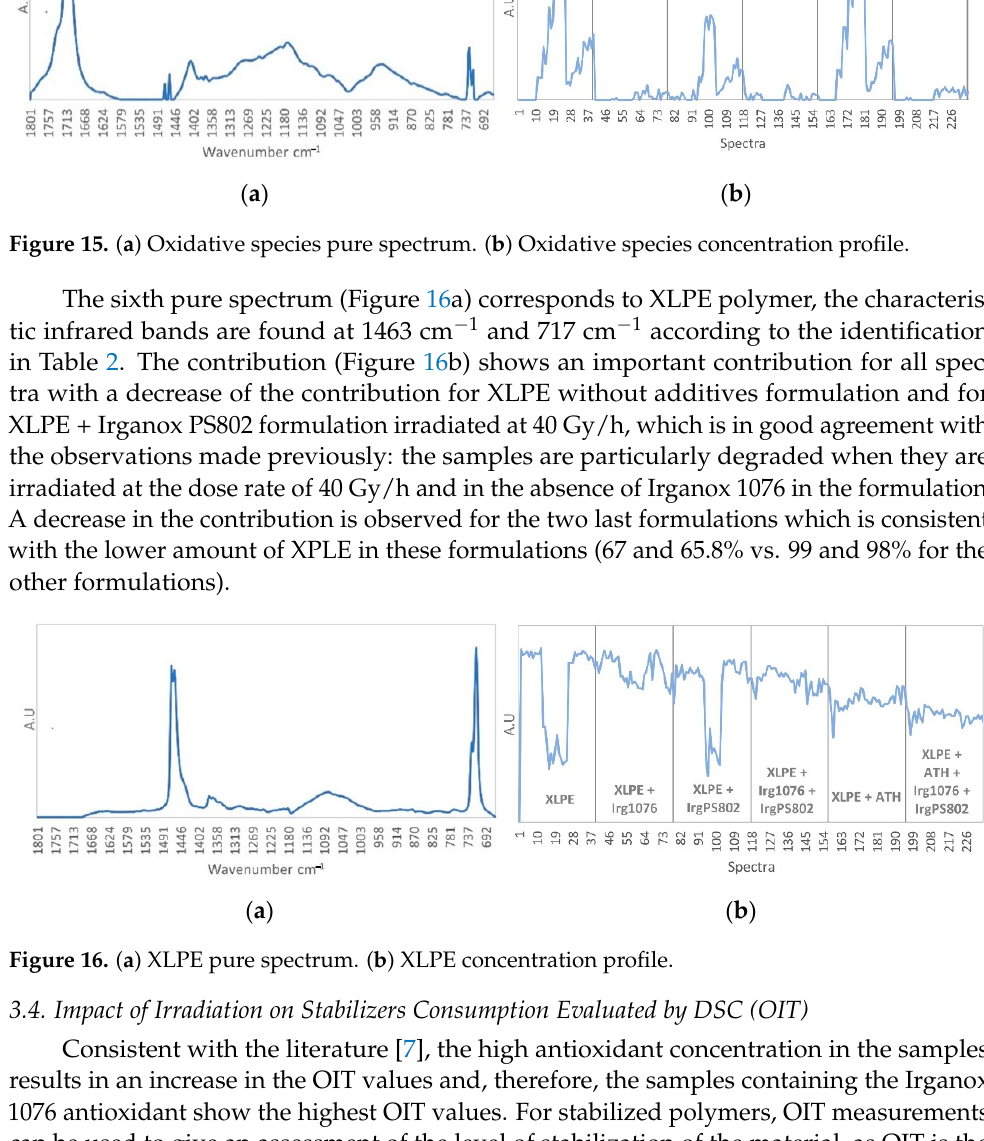
Figure 17. Remaining percentages of initial oxidative induction time (OIT) for the different samples (full markers: samples irradiated at 40 Gy/h, empty markers: samples irradiated at 300 Gy/h). Figure 17 shows clearly that the samples without Irganox 1076 are totally oxidized from the first irradiation dose, which shows that the additives Irganox PS802 (heat stabi- lizer additive) and ATH (flame-retardant additive) do not have antioxidant properties. These results seem to show that Irganox PS802 is totally consumed at low doses, but pre- vious infrared studies allow more precise interpretation and highlights that the degrada- tion of Irganox PS802 is not complete for the high dose rate.